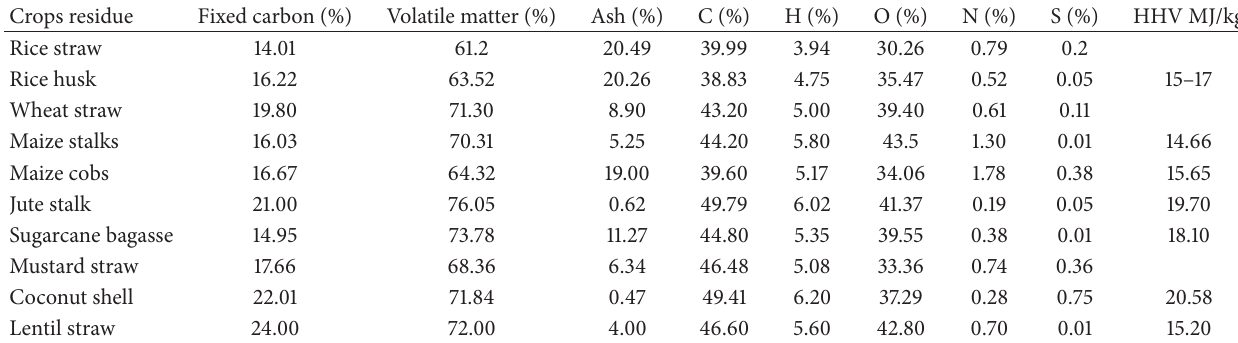
Table 4: Proximate and ultimate analysis of some selected agricultural residues [8,